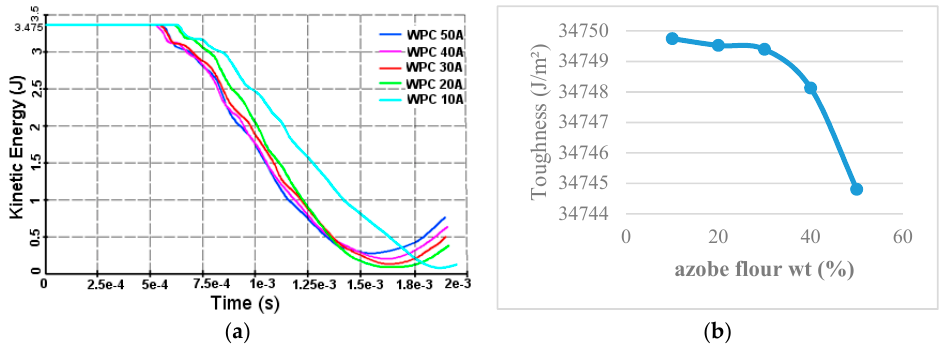
Figure 12. Time dependence of energy absorbed during the Charpy impact.